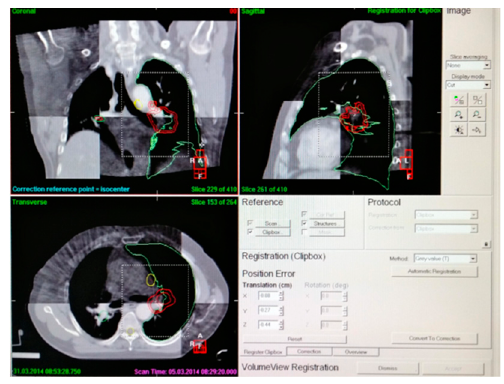
Figure 4. Cone beam computed tomography (CBCT) image calibration and positioning error calculation.